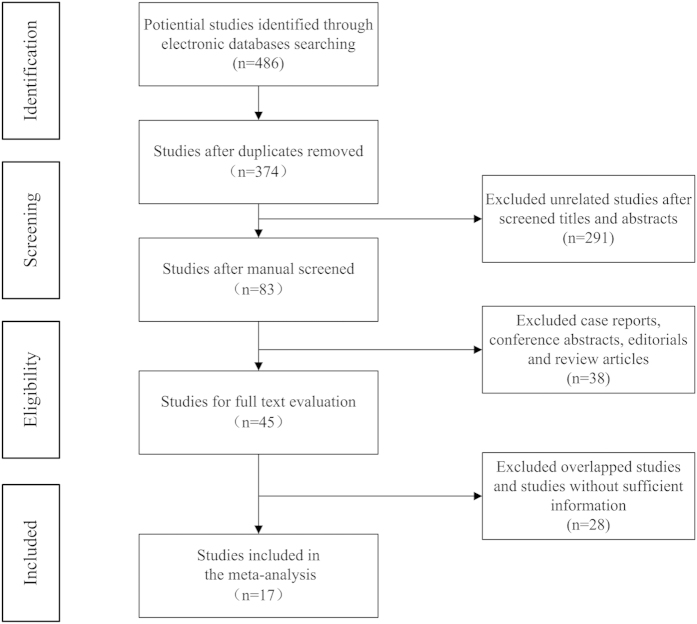
Flow chart of study selection.